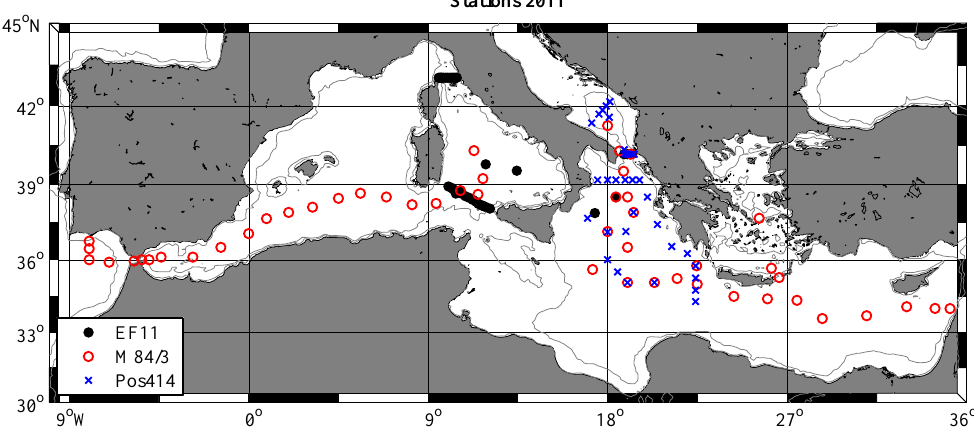
Fig. 1. Map of the Mediterranean Sea with the positions of the three quasi-synoptic cruises marked, see text. The 500m isobaths are marked with a thin gray